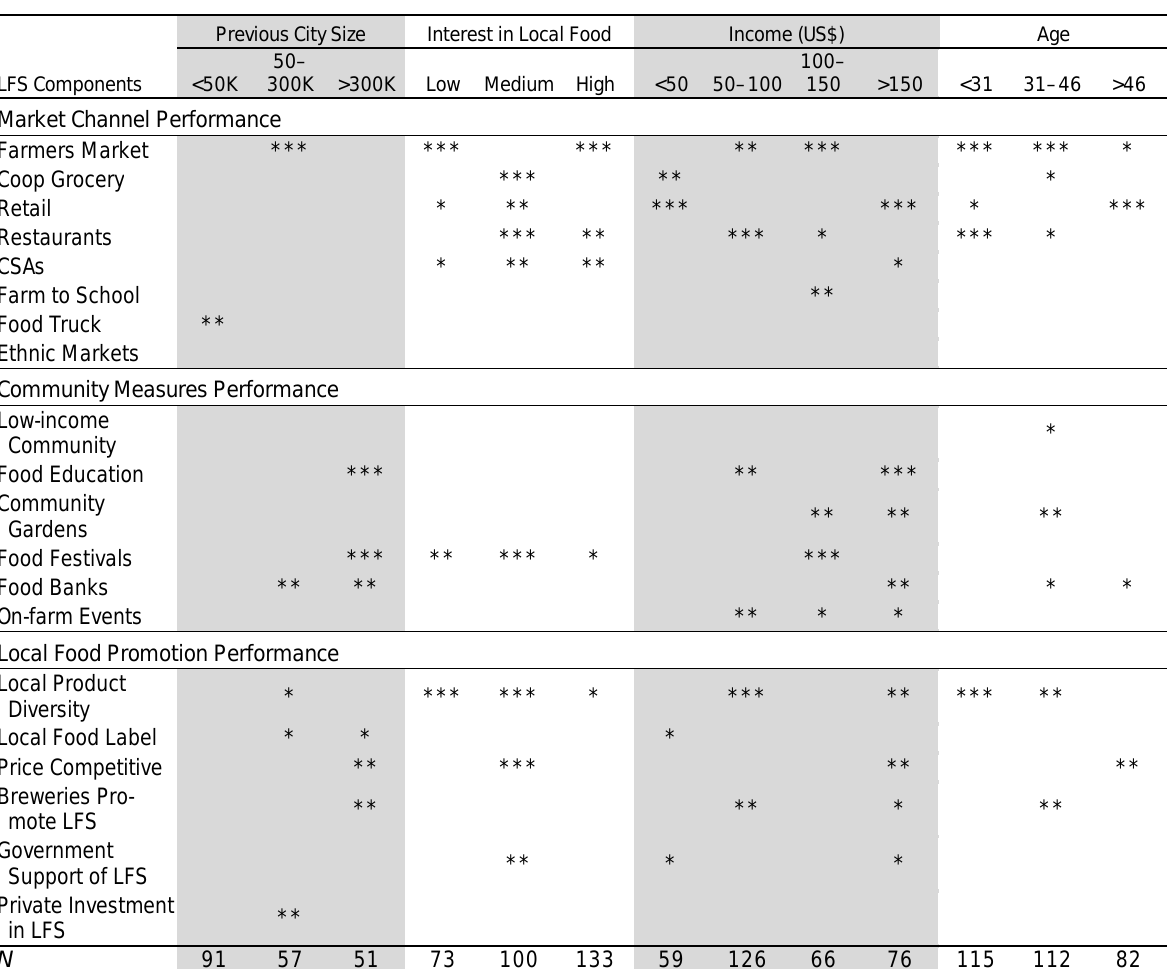
Table 5. Logistic Regression Results by Resident Segment